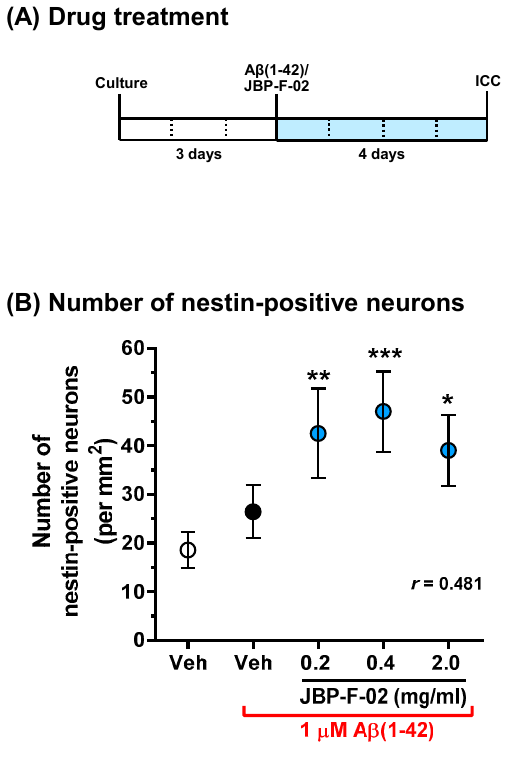
Figure 4. Effect of JBP-F-02 on neurogenesis under A β 1–42 treatment. ( A ) Cortical neurons were cultured for 3 days and then treated with or without aggregated A β 1–42 (1 µ M). At the time of A β 1–42 addition, the cells were simultaneously treated with JBP-F-02 at 0.2, 0.4, and 2 mg/mL concentration or a vehicle solution (distilled water). Four days after the treatment, the cells were fixed and immunostained for nestin and MAP2. ( B ) Nestin-positive and MAP2-positive cells were counted as neuronal stem cells; * p < 0.05, ** p < 0.01, *** p < 0.001 vs. A β 1–42-treated and vehicle solution-treated cells (black circle), one-way analysis of variance with post hoc Bonferroni’s test, n = 32 photos. Means ± 95% CI. A β , amyloid β .